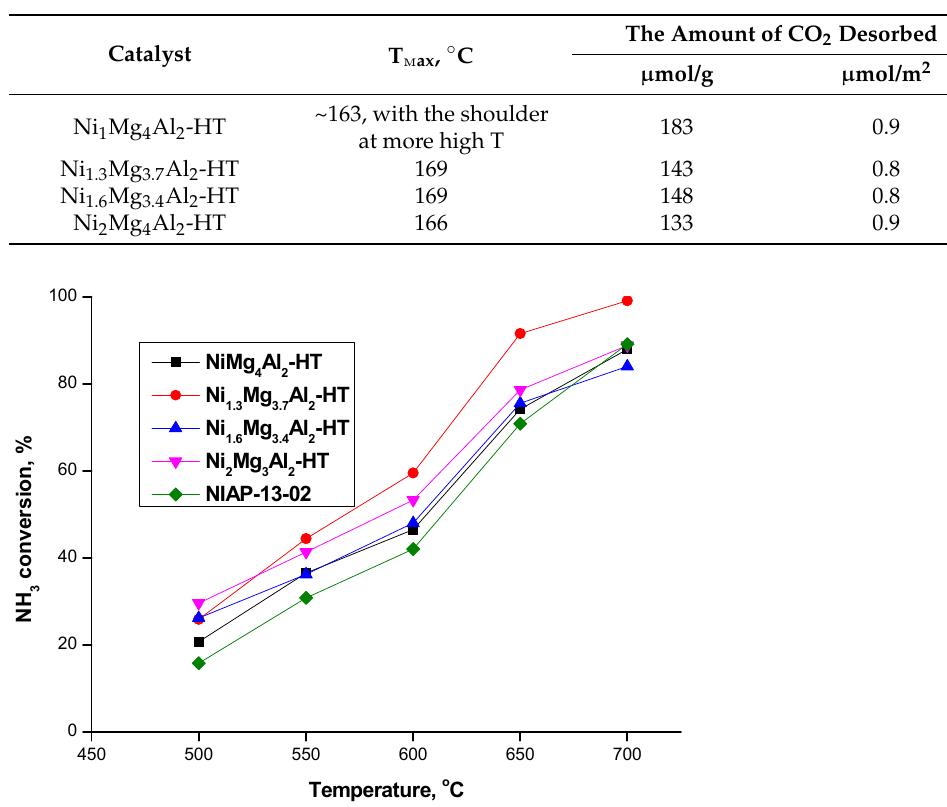
Figure 4. CO 2 –TPD profiles of calcined Ni x Mg y Al 2 -HT catalysts (600 ◦ C). Table 2. The basicity of Ni x Mg y Al 2 -HT catalysts determined by the method of temperature-programmed CO 2 desorption.